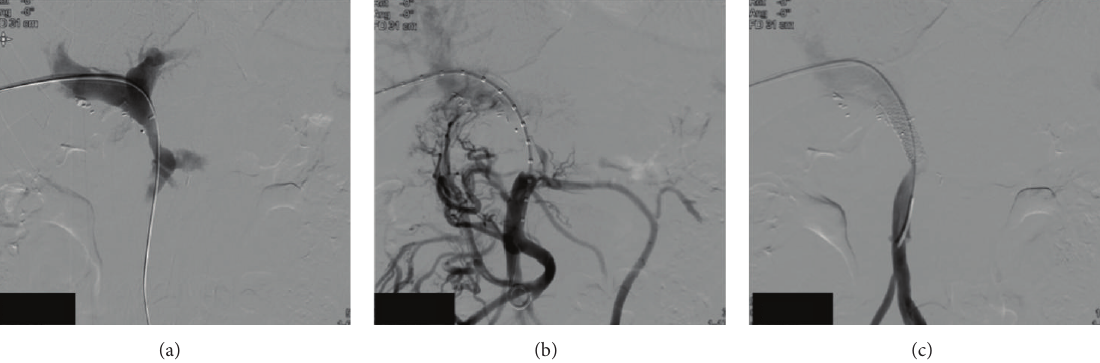
Figure 2: (a) Percutaneous portography. A segmental stenosis is noted cranial to the portal vein—splenic vein junction. (b) Percutaneous portography. As a consequence of the portal vein stenosis, extensive collateralisation takes place. (c) Percutaneous portography. After balloon dilation, a stent is inserted. Angiographic control confirms the improved lumen diameter and immediate loss of compensatory collateral flow.